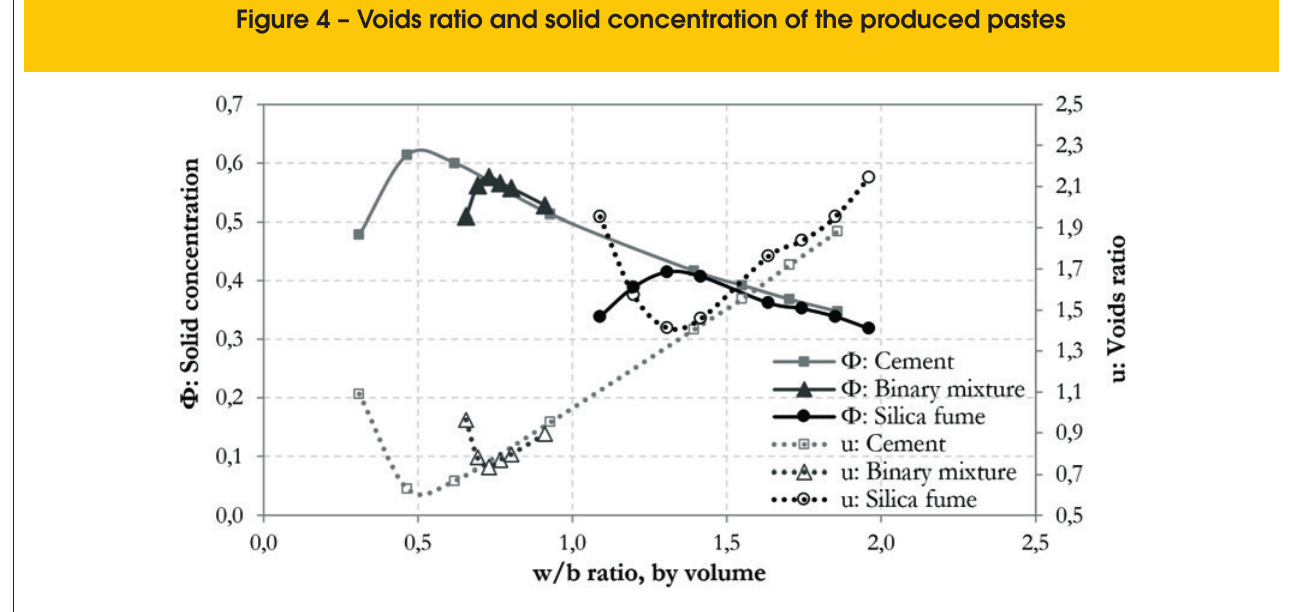
Figure 4 – Voids ratio and solid concentration of the produced